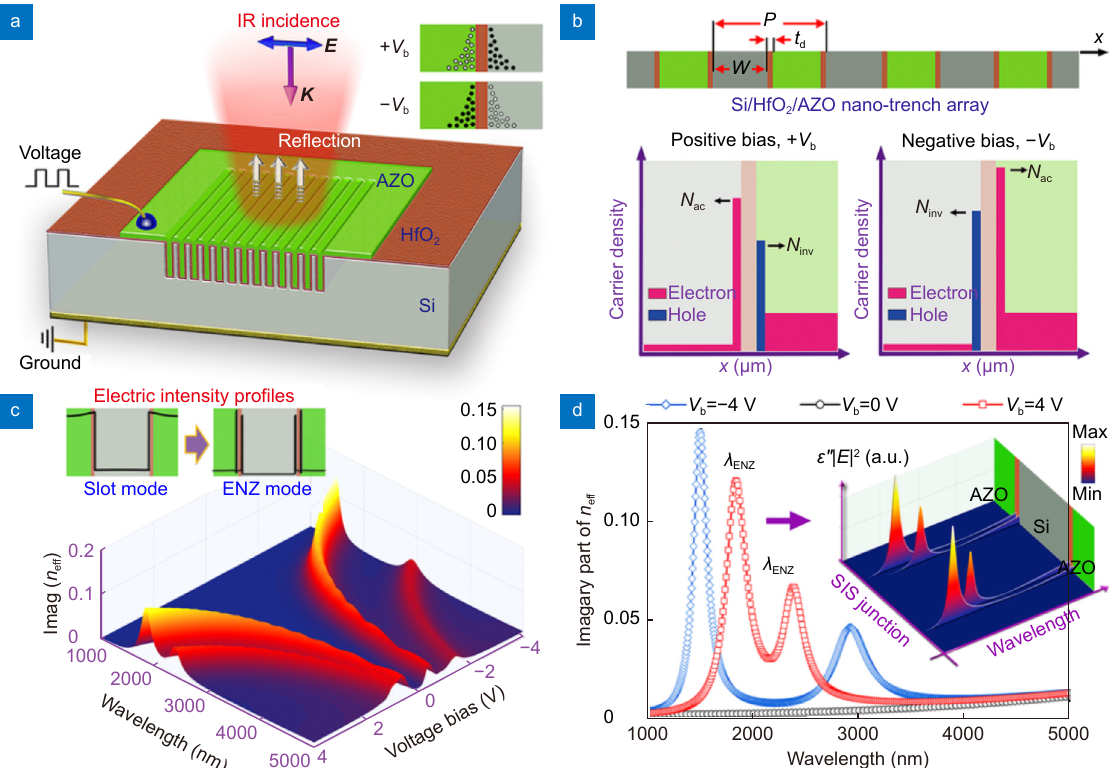
Fig. 1 | ( a – b ) The schematic drawing of the deep nanotech-based SIS capacitor for broad-band spectral E-O modulation. Under external voltage biasing, the capacitor encounters charge accumulation at both sides of the SIS junction. With a sufficiently high carrier density, dual ENZ confine- ments can be anticipatedin the nanometer thin layers which results insubstantial E-O absorption along the sidewall of the nanotrench. Herein, the period of the nanotrench ( P ) is 300 nm, the width of the silicon wall is a half of the period ( W = P /2), and the thickness of HfO 2 ( t d ) is assumed to be 8 nm. The background doping level of AZO and silicon is 2×10 18 and 2×10 17 cm −3 , respectively. ( c ) The evolution of the mode loss character- istics in the SIS nanotrenchas a function of wavelength and voltage bias. The upper plot shows two typical mode field profiles associated to with and without a voltage bias. ( d ) The imaginary part of the effective mode index ( n eff ) plotted at three selected voltages (i.e., V b =−4, 0 and 4 V). The inset is P abs of the eigenmodes plotted in the spatial and spectral domains, which illustrates the localized energy absorption properties of the two distinct ENZ modes ( V b = 4